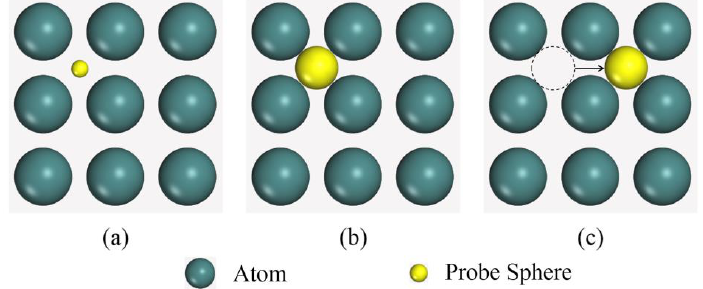
Figure 4. A diagrammatic sketch for searching all possible unfilled spaces in a structural model, including three steps: ( a ) location of an unfilled space, ( b ) size or volume evaluation of an unfilled space, and ( c ) the next unfilled space.